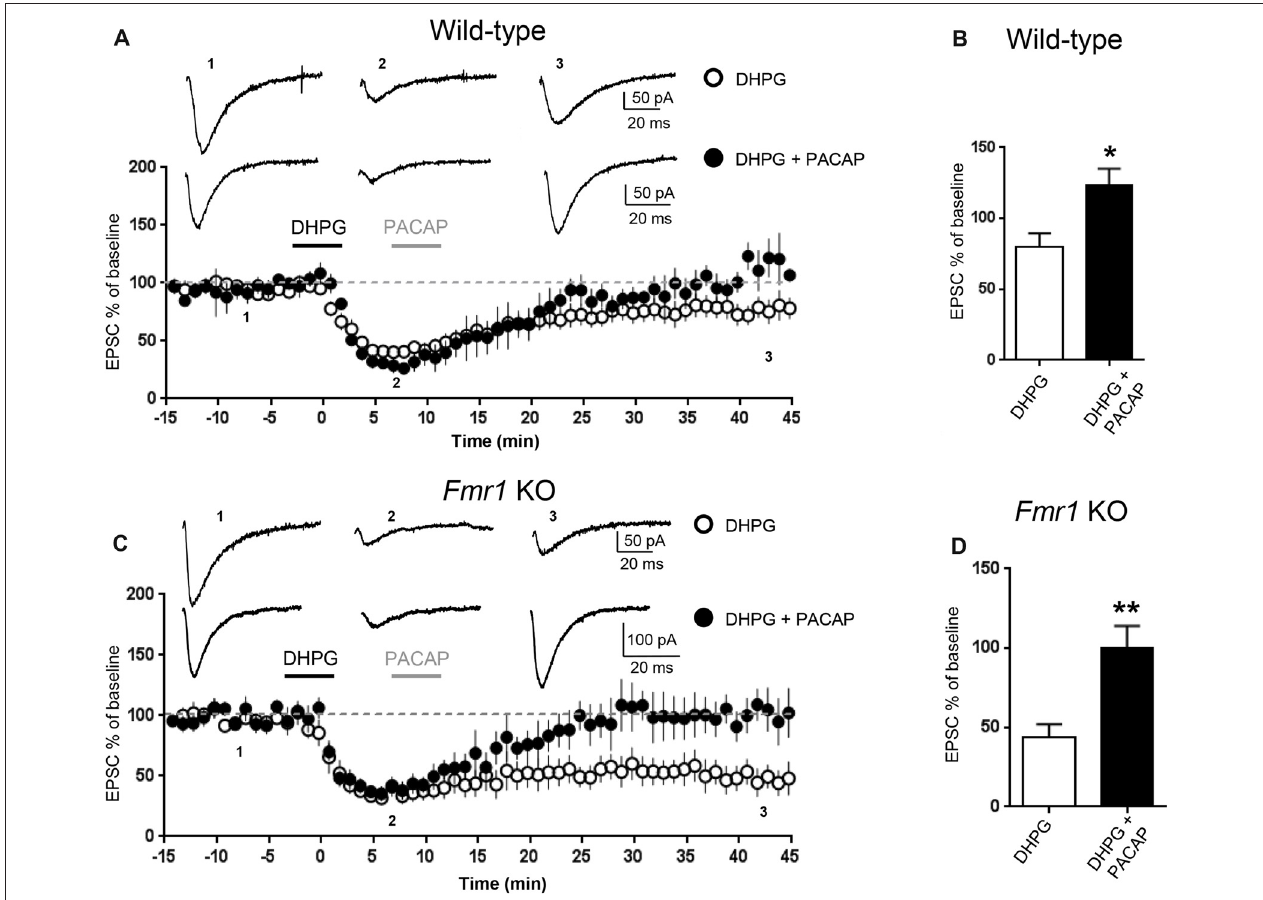
FIGURE 2 | Pituitary adenylate cyclase activating peptide (PACAP) reversed mGluR-LTD in WT and in Fmr1 KO hippocampus. mGluR-LTD was induced by application of DHPG (100 µ M, 5 min). Application of PACAP (10 nM, 5 min) fully reversed DHPG-induced mGluR-LTD in WT (A) and in Fmr1 KO slices (C) . (B,D) Reversal of mGluR-LTD by PACAP was statistically significant both in WT ( ∗ P = 0.04, by unpaired t -test) and in Fmr1 KO slices ( ∗∗ P = 0.0025, unpaired t